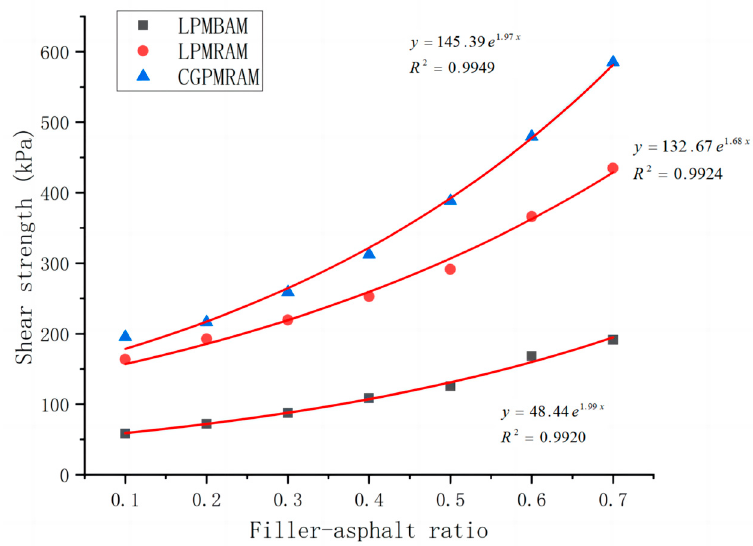
Figure 6. Relationship curves of shear strength and filler-asphalt ratios.